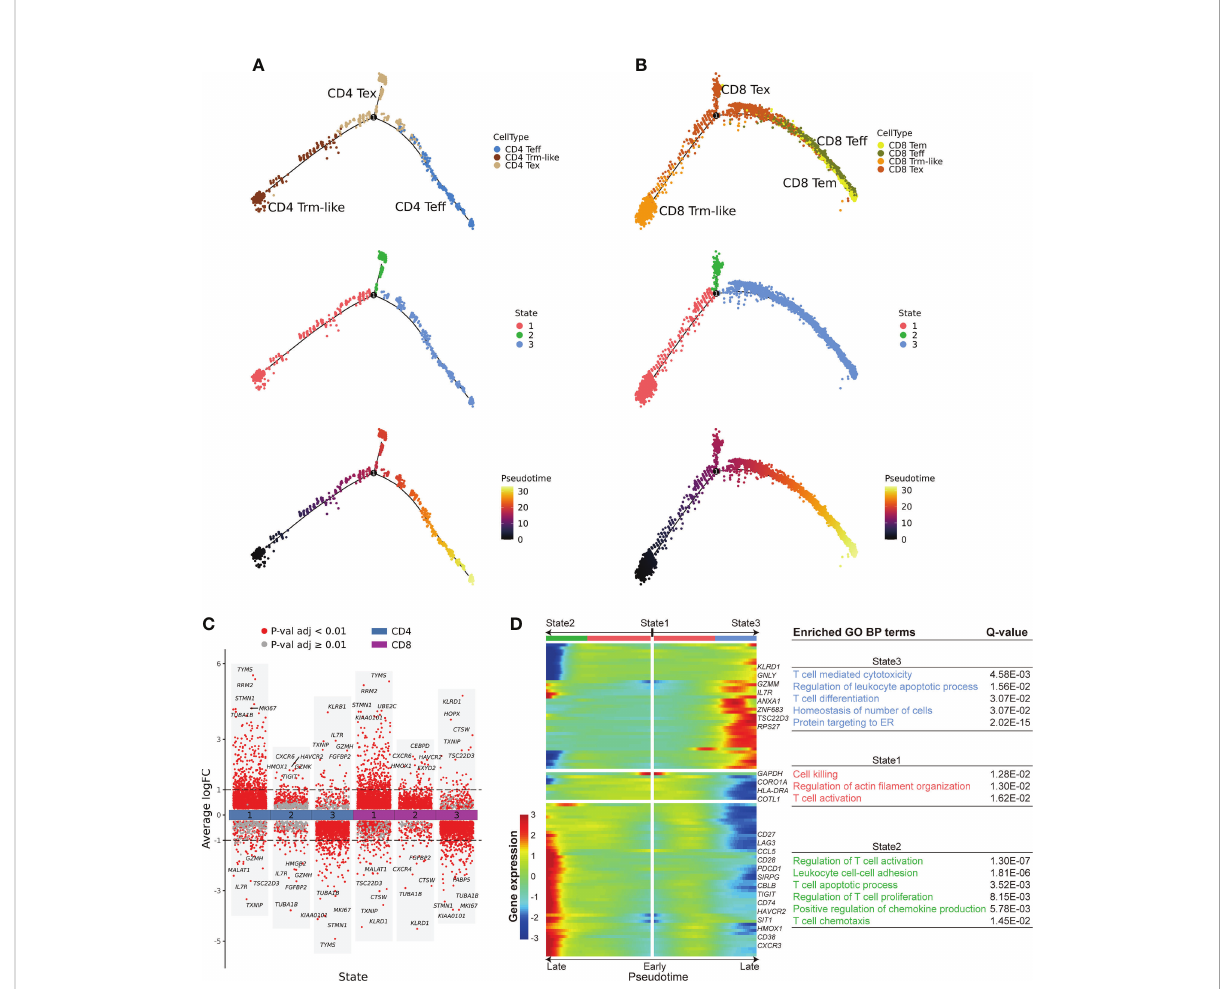
FIGURE 4 Cell fate trajectory of T cells from B-ALL patients. (A). The discriminative dimensionality reduction (DDR) tree visualization of selected subtypes of CD4+ T cell trajectory with cell type (top), state (middle), and pseudotime (bottom) information mapping, respectively. (B). Same as panel (A) but for selected CD8+ T-cell subsets. (C). Gene expression fold change between T cells in distinct cell fate trajectory states. The expression fold change of each gene in a T-cell state is determined by comparing to the average expression of the same gene in the other two states. (D). Left: expression heatmap of the top 100 genes that had the most signi fi cantly correlated (or anti-correlated) expression pro fi le to the CD8+ T-cell fate pseudotime in panel (B) The correlation signi fi cances (Q values) were calculated by branched expression analysis modeling (BEAM). Right: enriched GO biological process terms for genes that were speci fi cally expressed in CD8+ T cells of each